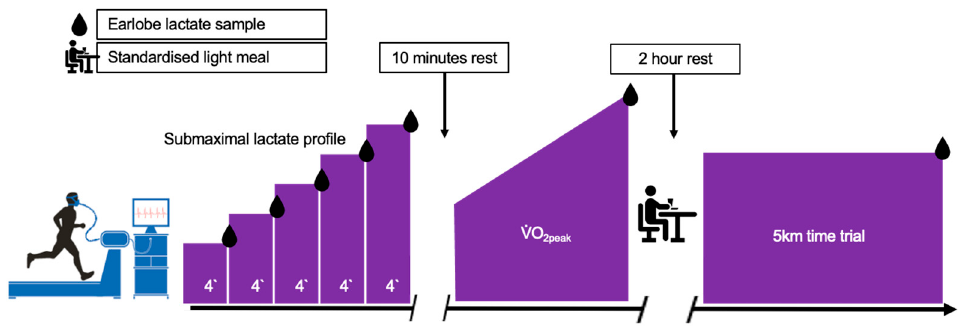
Figure 1. Schematic representation of the study design on Trial 1 and Trial